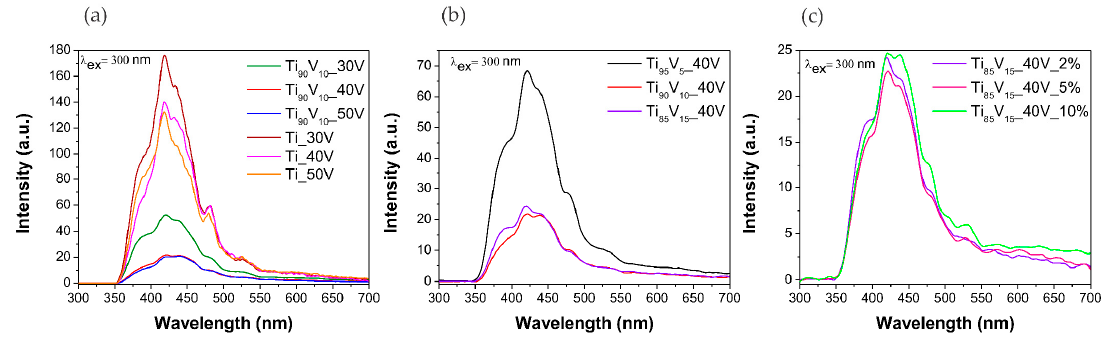
Figure 5. Photoluminescence spectra of pristine TiO 2 NTs and V 2 O 5 -TiO 2 NS. Effect of ( a ) anodization potential; ( b ) vanadium content in the alloy; and ( c ) water content in the electrolyte.